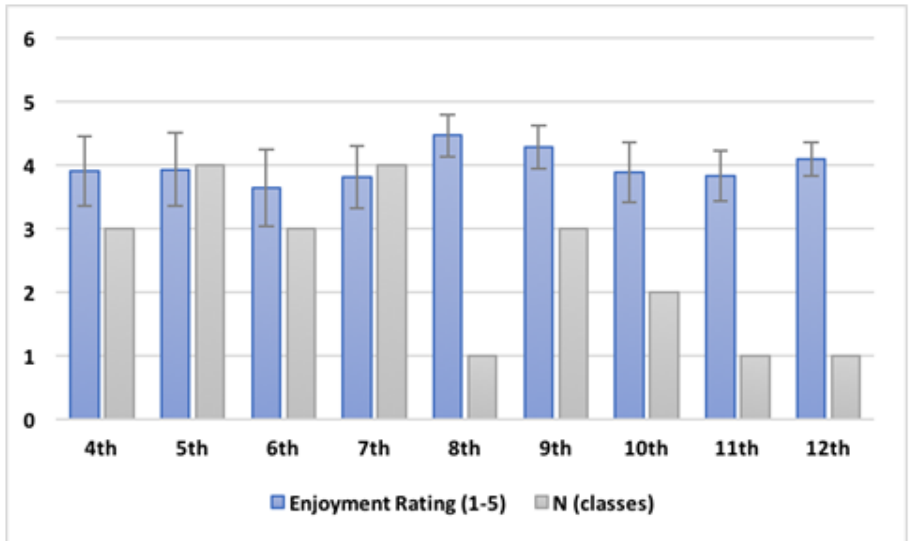
Figure 6. Student enjoyment of science